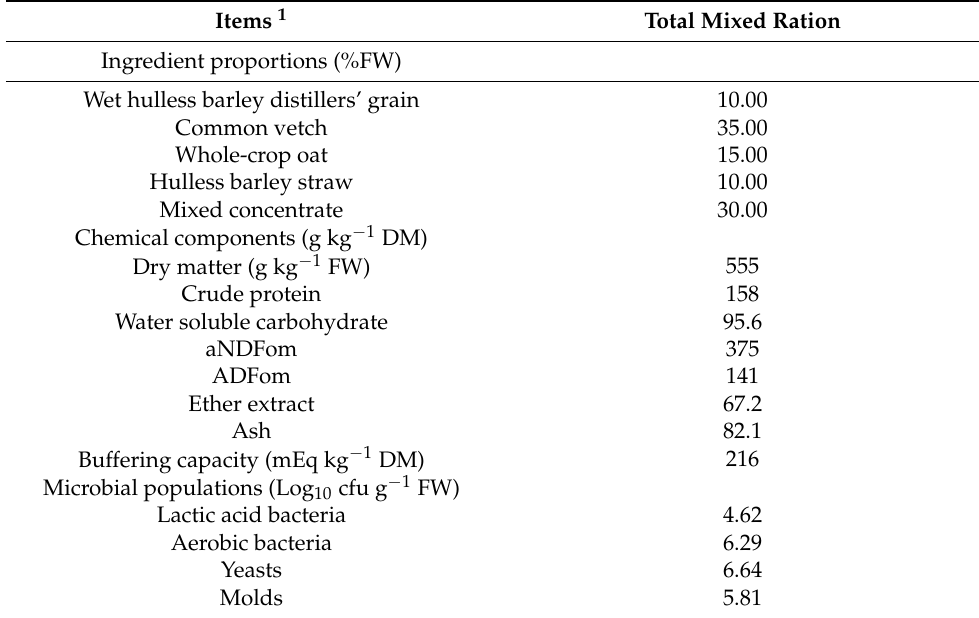
Table 2. Ingredient proportions, microbial and chemical compositions of pre-ensiled total mixed